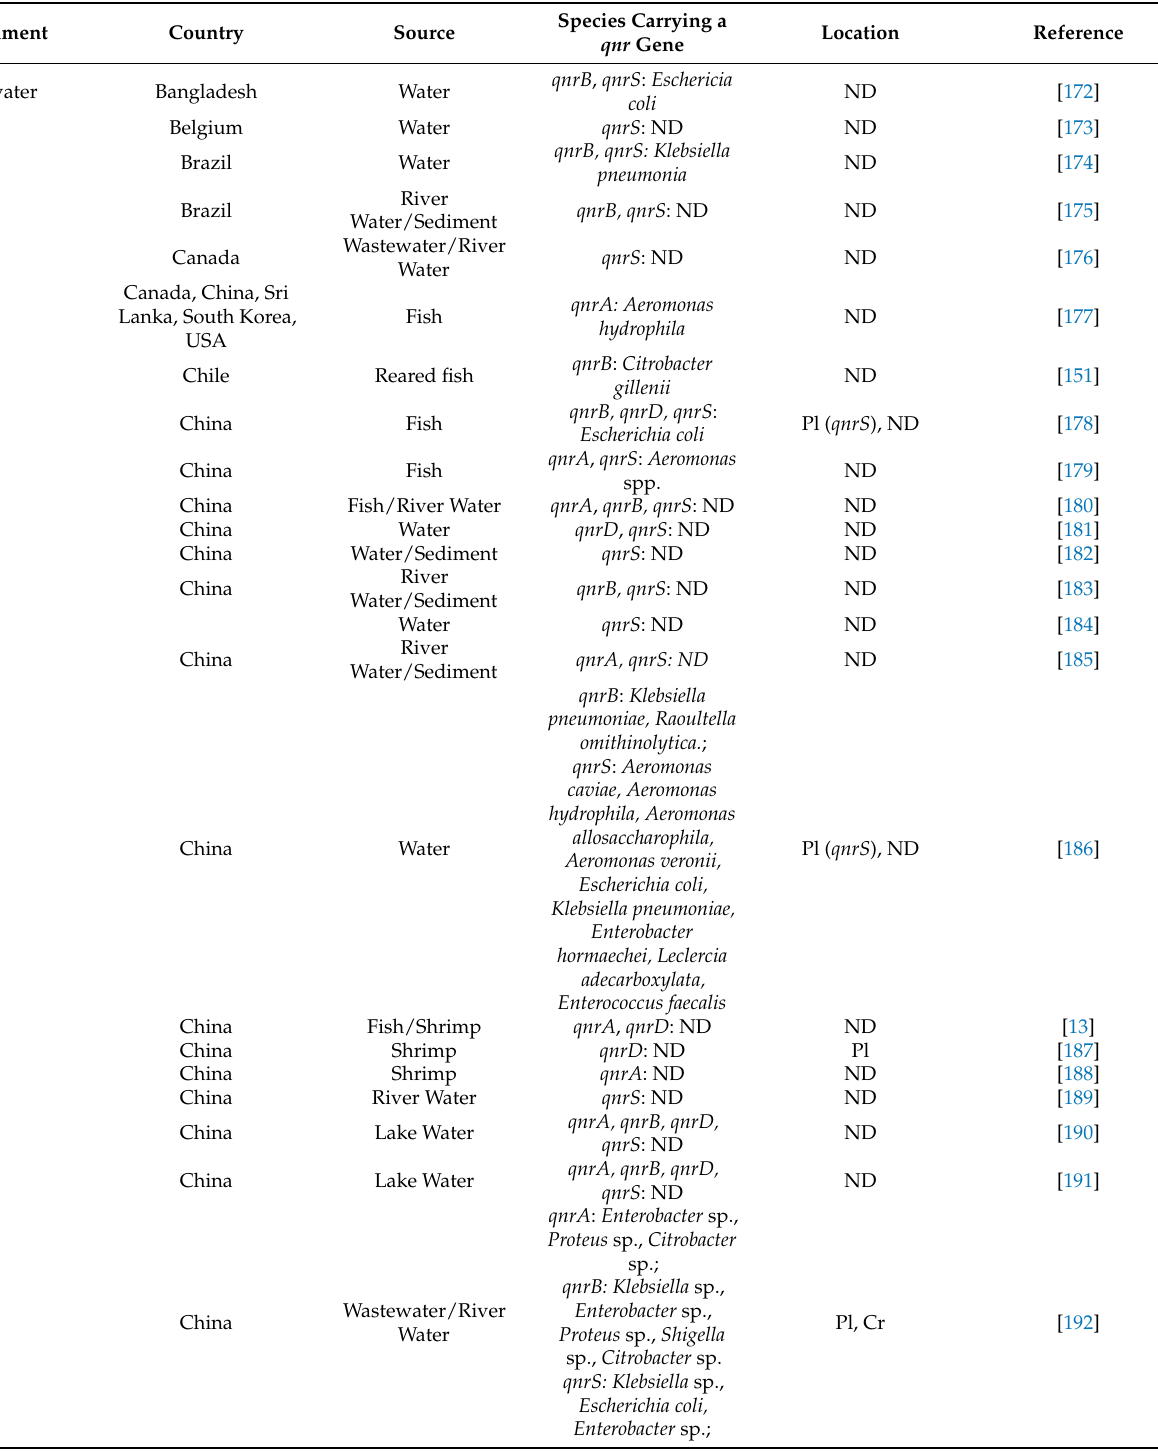
Table 4. Detection of qnr genes in bacteria isolated from aquatic